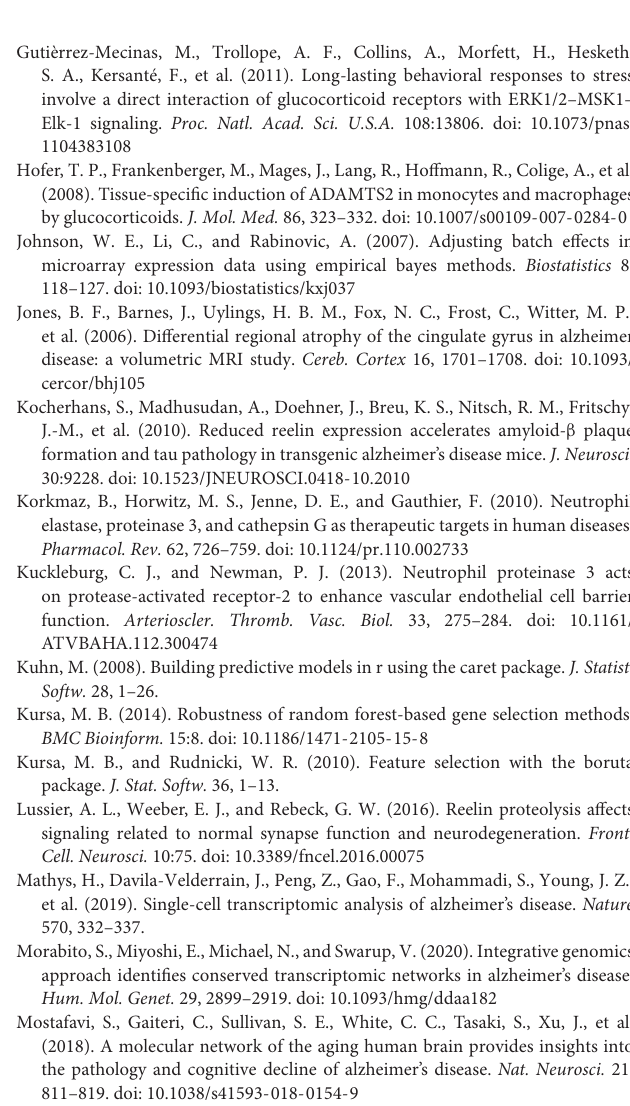
Supplementary Table 6 | Complete Boruta results from the pathology